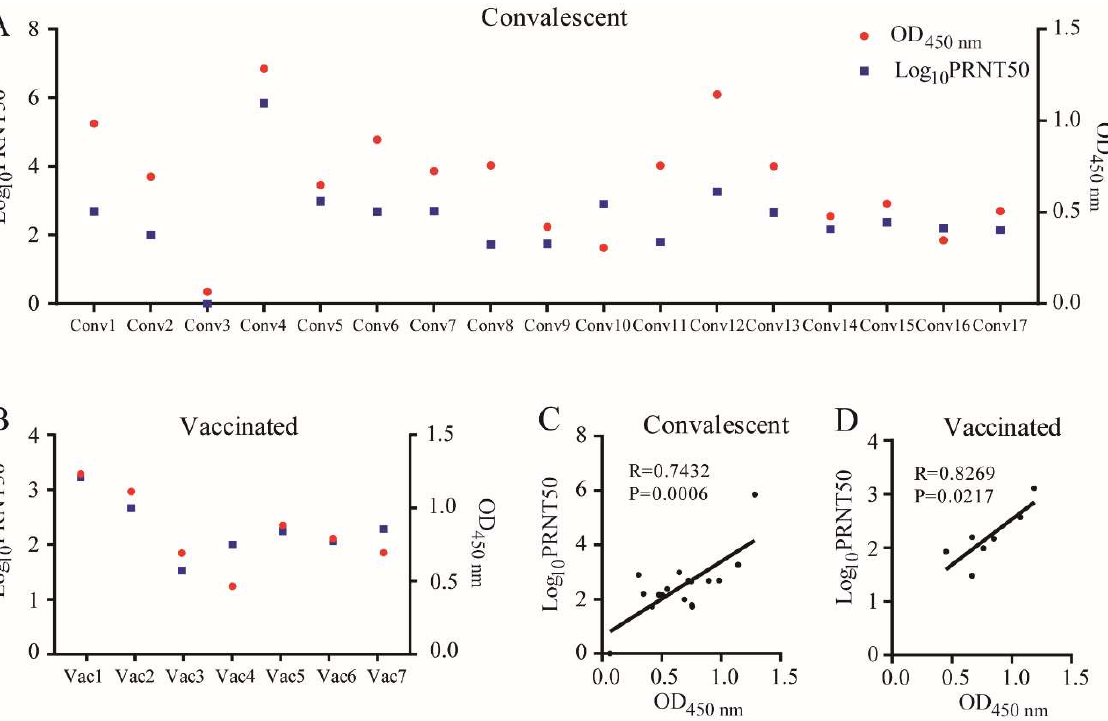
Figure 1. The correlation relationship between PRNT50 and OD 450 nm of ELISA (with sera dilution of 1:20). ( A ) PRNT50 (neutralization titers) of the seventeen convalescent sera and the corresponding OD 450 nm of ELISA; ( B ) PRNT50 of the seven vaccinated sera and the corresponding OD 450 nm of ELISA; ( C ) The correlation plots between the OD 450 nm and FRNT50 for the virus B.1. ( D ) The correlation plots between the OD 450 nm and PRNT50 for the virus